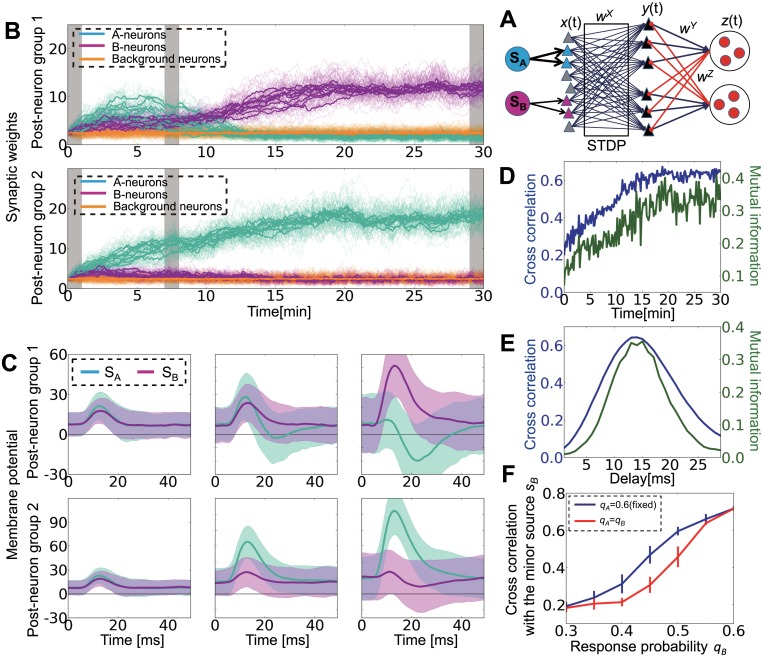
Lateral inhibition enables minor source detection by spike-timing-dependent plasticity (STDP) through membrane hyperpolarization.(A) Schematic figure of the simplified model. SA and SB (on the left side) are the sources that project to subsets of input neurons (colored triangles). Gray triangles are background neurons, black triangles (on the right) are output neurons, and red circles are inhibitory neurons. (B) Development of synaptic weights. Thick lines are mean synaptic weights from A-neurons (blue), B-neurons (red), and Background-neurons (orange) to each output neuron. Thin lines are traces of individual synaptic weights. Gray bar shows the timing at which figure C is calculated. (C) Peristimulus time histograms (PSTHs) of membrane potentials averaged within output neuron groups. T = 0 indicates the timing of events at external layers. The three figures are calculated from the data at t = 0–1 min, 7–8 min, and 29–30 min. (D) Development of mean cross-correlation and mutual information between external sources and population activity of output neurons for the simulation depicted in panels B and C. (E) Delay dependence of mean cross-correlation and mutual information. Both values were calculated from five simulations. (F) Cross-correlation between the output group that detected the minor source and the minor source activity for various response probabilities q
B with a fixed q
A (= 0.6). When none of output groups detected the minor source, the larger value calculated for the two output groups was used. Throughout the study, error bars represent standard deviation calculated from five simulations, unless otherwise indicated.